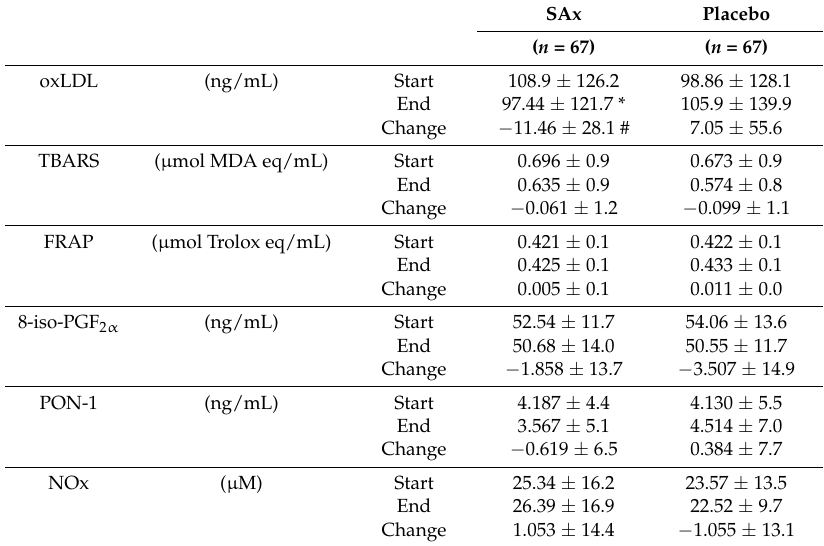
Table 4. Oxidative status at the start and end of the supplementation and placebo periods.